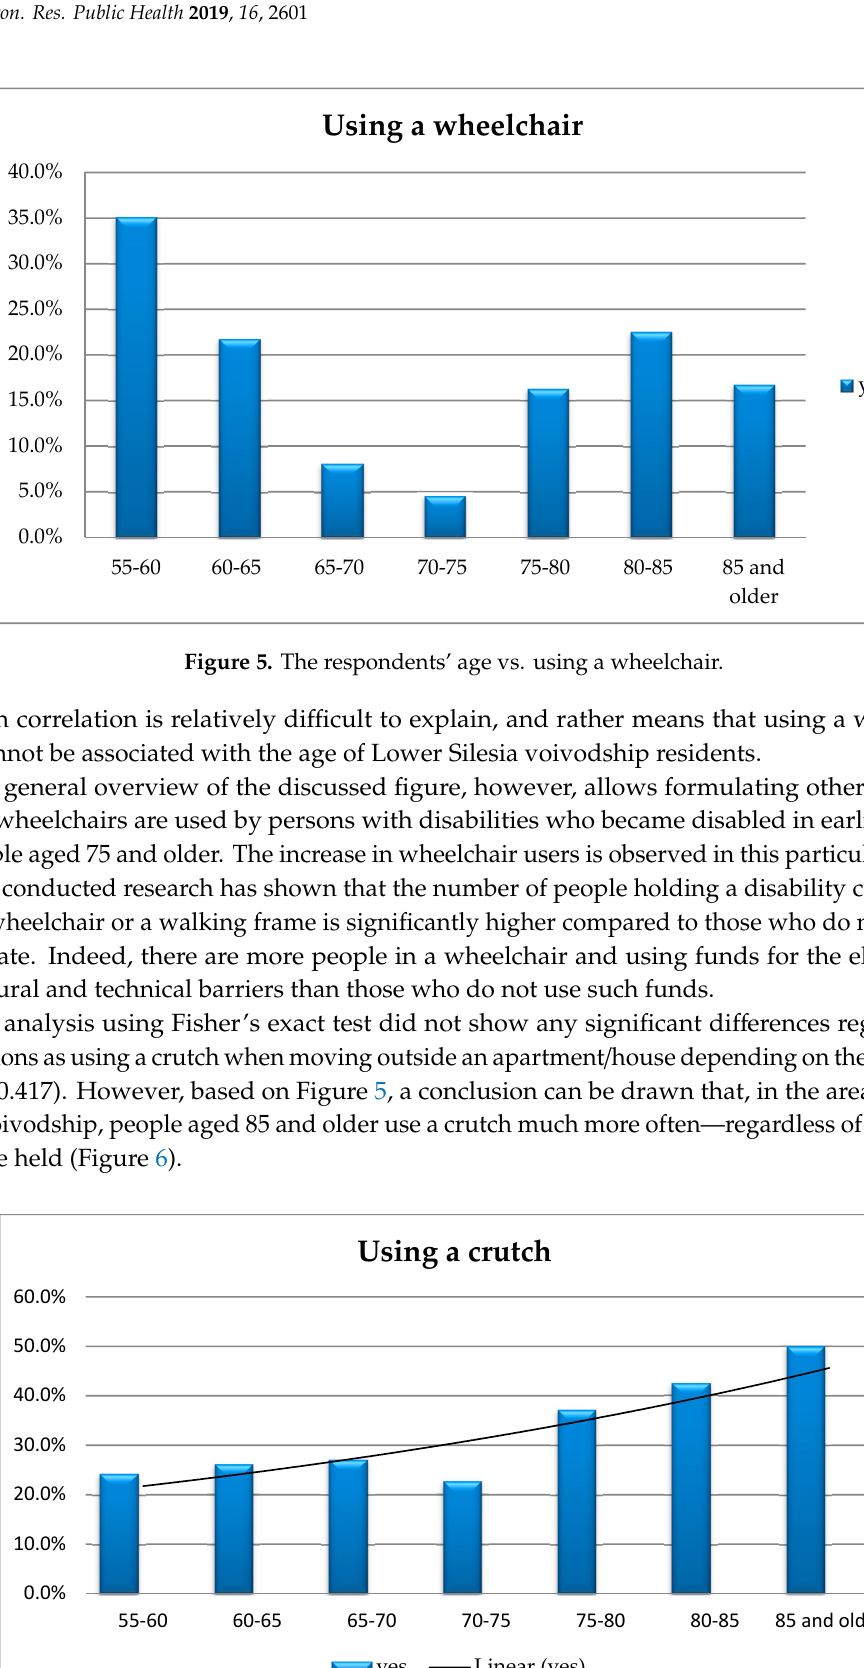
Figure 7. The respondents’ age vs. using a walking frame.